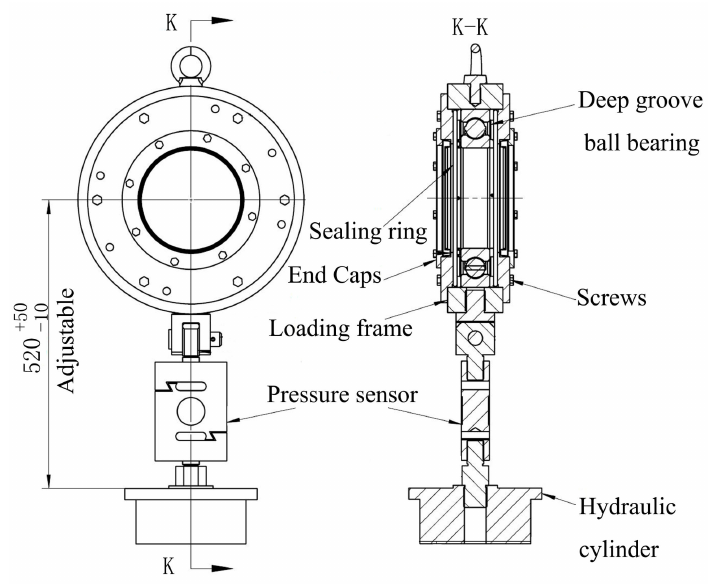
Figure 1. Schematic Diagram of Test Equipment.